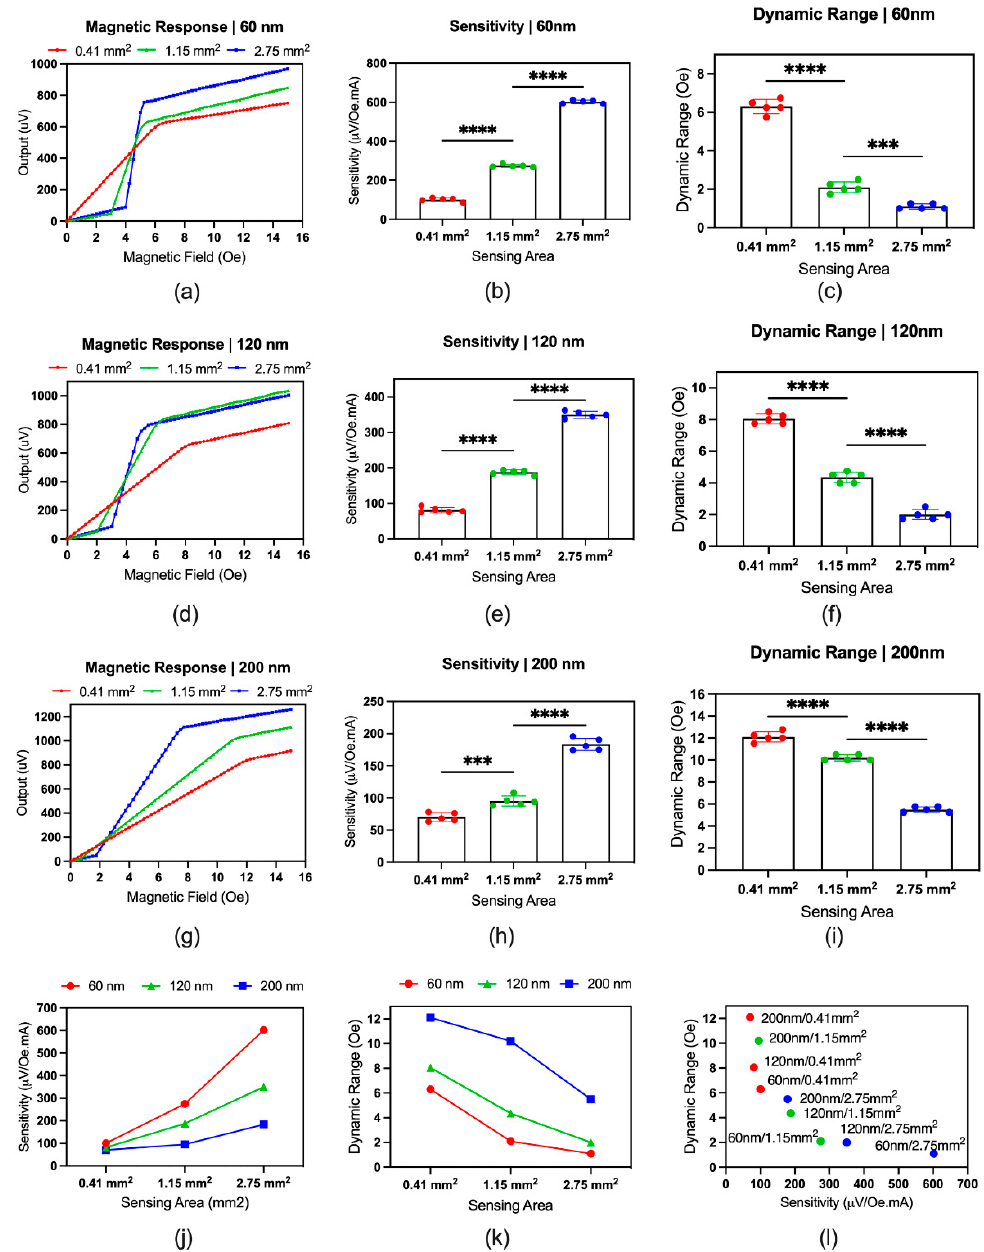
Figure 4. Comparison of the sensor variants: ( a – i ) magnetic response, sensitivity, and dynamic range of 60 nm, 120 nm, and 200 nm sensors. In figure ( a , d , g ) the dots represent the mean of 5 sensors. In figure ( b , c , e , f , h , i ), the dots represent the individual measurement of different sensors. The statistical significance was based on the ordinary one-way ANOVA (multiple comparison), where p = 0.1234 (non-significant, ns), 0.0002 (***), and < 0.0001(****). ( j ) Sensitivity comparison of the sensor variants; ( k ) dynamic range comparison of the sensor variants; ( l ) trade-off between sensitivity and dynamic range. In ( j – l ), the dot indicates the mean, where n =